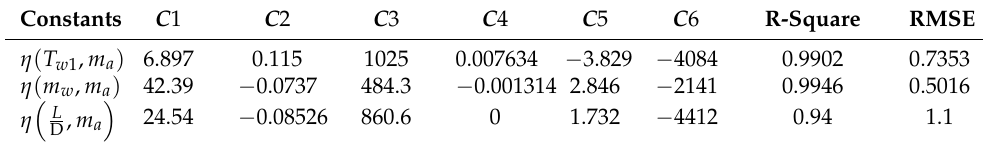
Table 2. Constant parameters, correlation coefficient, and RMSE for Equations (10)–(12). Constants C